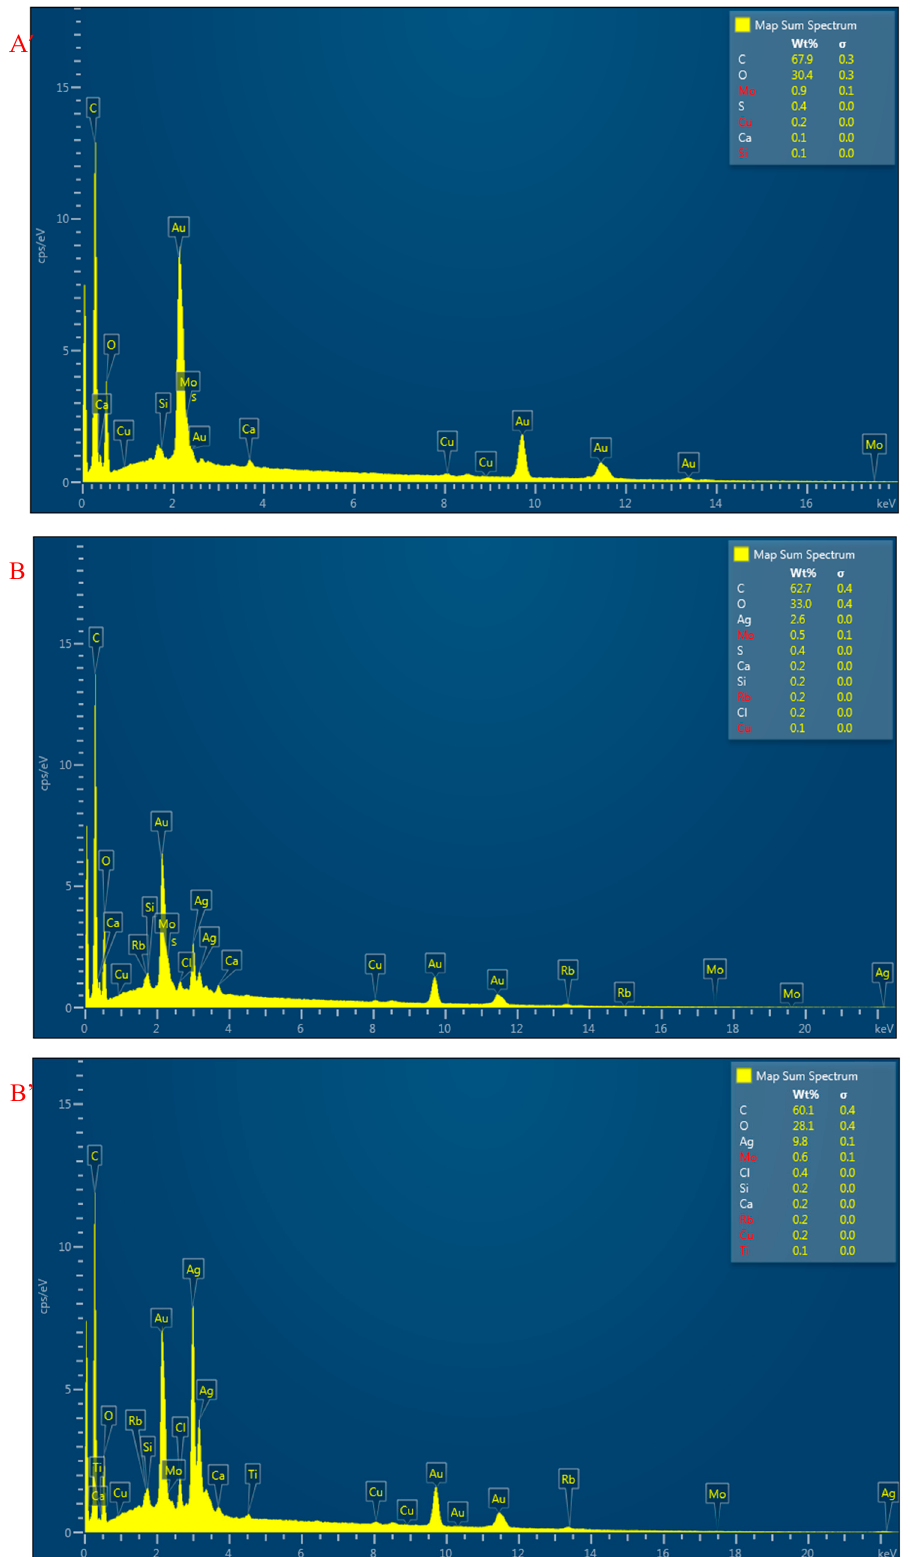
Figure 6. SEM-EDX results for both sides of two Song Brocade fabrics (( A , A’ ): the front side and back side of sample S1; ( B , B’ ): the front side and back side of sample S2).